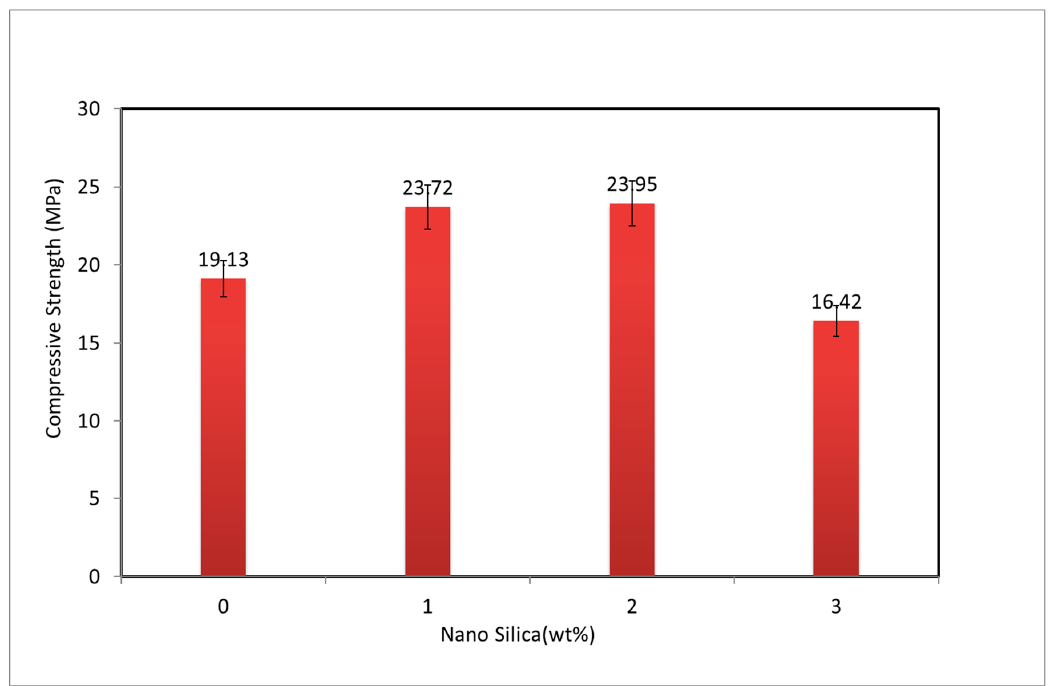
Figure 2. Compressive strength of PVA fiber-reinforced geopolymer composites (PVA-FRGC) at various nanosilica contents.